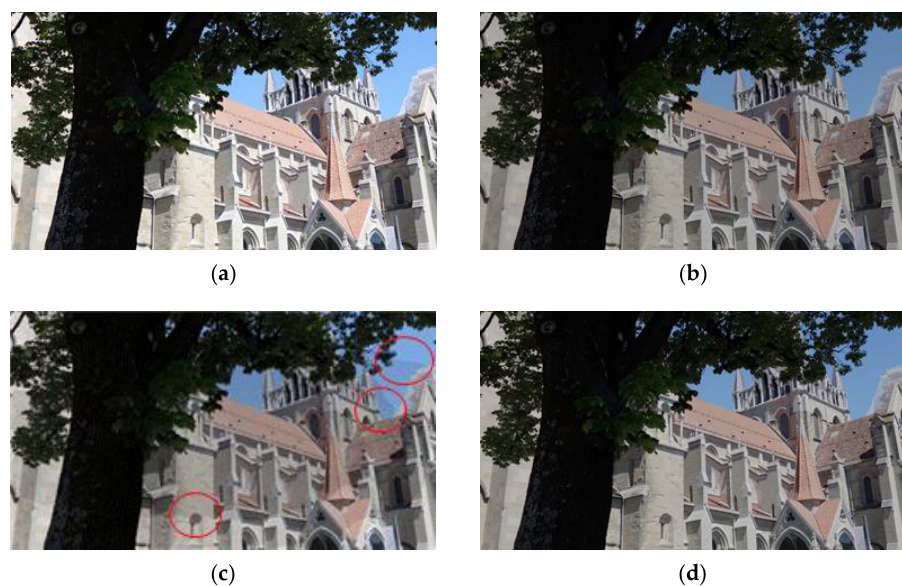
Figure 11. Comparison of the existing methods and proposed one: ( a ) original image, ( b ) global dimming, ( c ) saliency aware dimming, ( d ) proposed method.